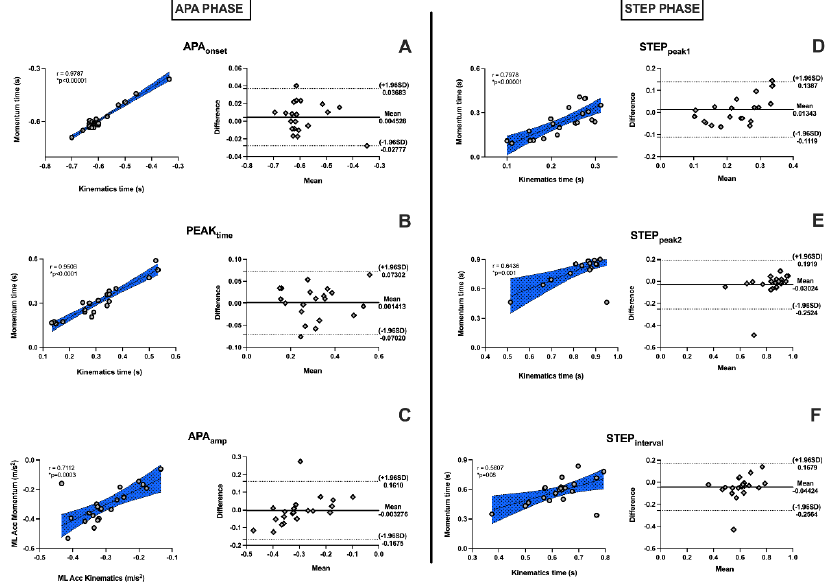
Figure 6. Linear correlation graphs and Bland–Altman correlation graphs showing high correlation between assessment instruments. r ≥ 0.7 represents very high correlation, and asterisk (*) represents values that present statistical significance ( p ≤ 0.05). Anticipatory variables are shown to left of graph, and step variables, after heel-off, to right. ( A ): APA onset ; ( B ): PEAK time ; ( C ): APA amp ; ( D ): STEP- peak1 ; ( E ): STEP peak2 , and ( F ): STEP interval .